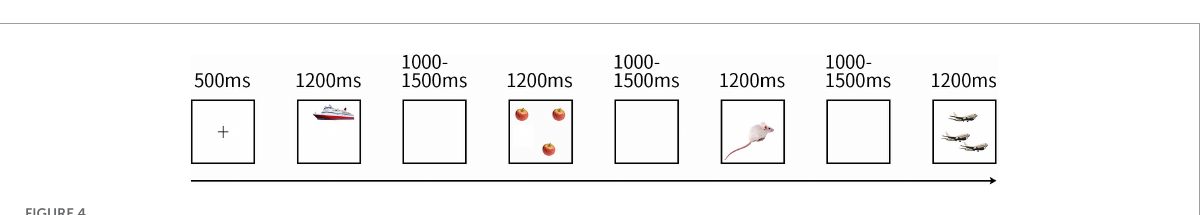
FIGURE4 Task Design of Experiment 2. The picture shows the design of the experimental task. All trials followed the depicted sequence. A block began with a fixation cross a picture. Then a singular – inanimate/plural – animate/singular – inanimate/plural – animate picture was displayed and participants were asked to name the objects rapidly after the stimuli were presented, followed by a blank screen (three pictures with similar pronunciation or the same quantity (singular vs. plural)/semantics (animate vs. inanimate) did not appear consecutively).